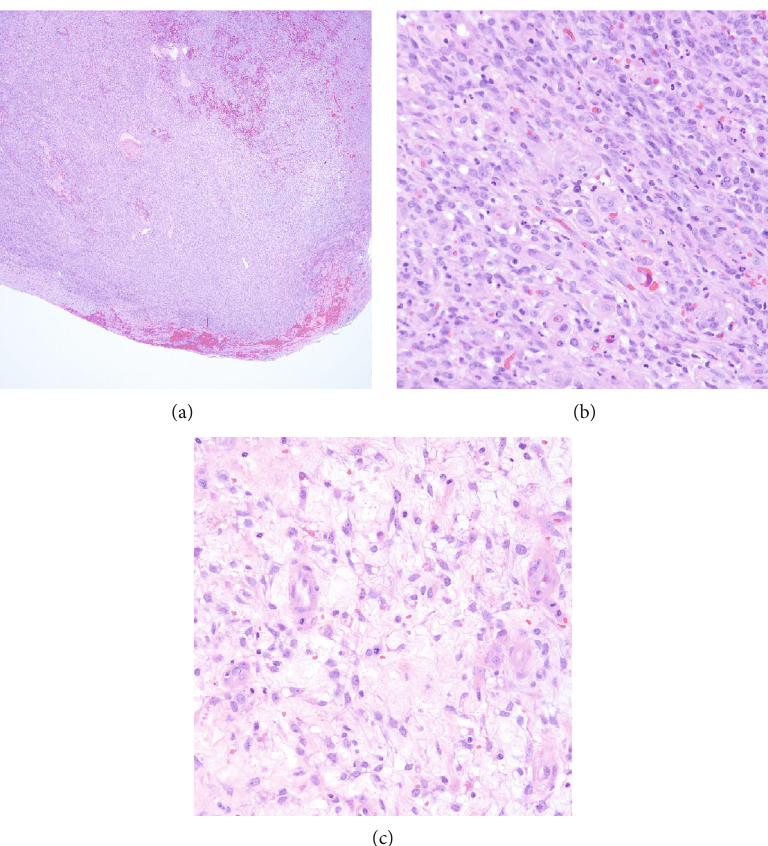
Figure 2: Histologic evaluation of a hand tumor indicative of monophasic synovial sarcoma. (a) At low power magni fi cation, a well- circumscribed hypercellular mass with areas of fi brosis and high vascularity can be seen. (b) The monophasic synovial sarcoma shows a densely packed, interlacing spindled cell proliferation with monomorphic cells arranged in a myxoid stroma. The nuclei are ovoid and pale-staining with small nucleoli. Rich vascularity is present. (c) High-magni fi cation revealing mitotic fi